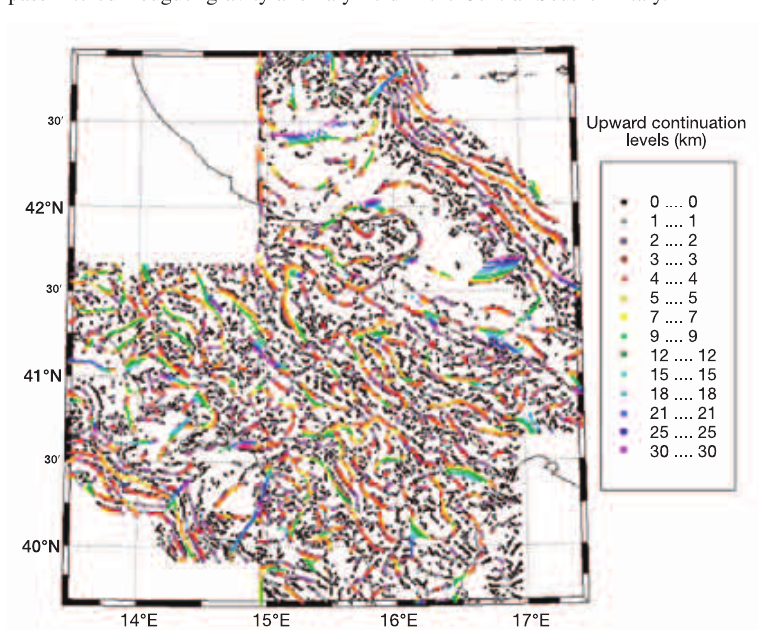
Fig. 8. High pass filtered Bouguer gravity anomaly field in the Central-Southern Italy.